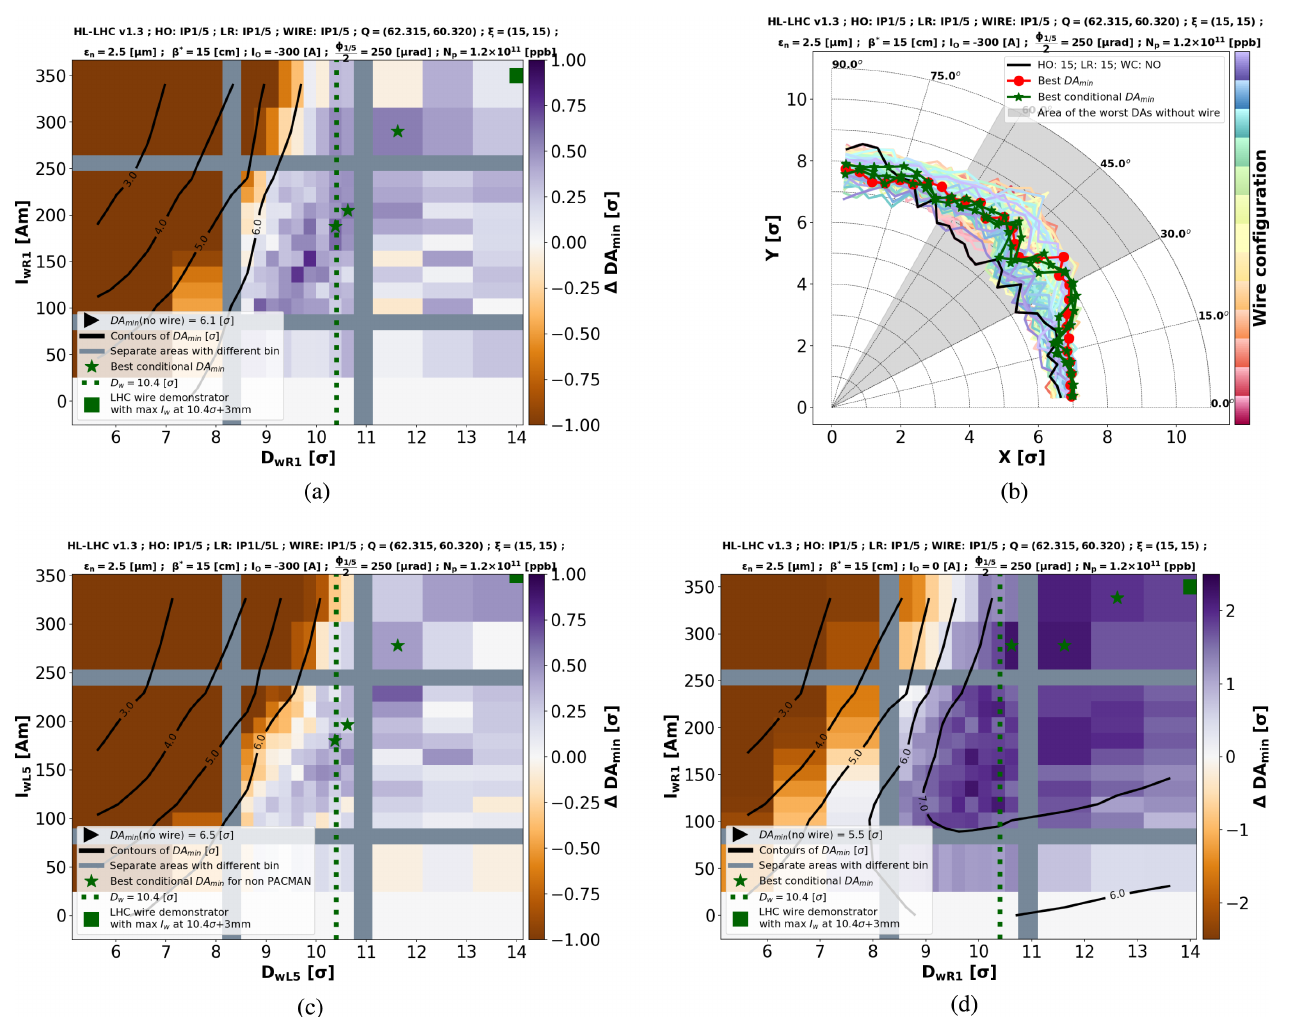
FIG. 4. HL-LHC nominal scenario at the end of the luminosity leveling. (a) The minimum DA difference from the case without wire ( Δ DA ) for different dc wire configurations and (b) DA values vs angles for the wire configurations that guarantee DA min (no wire). (c) Δ DA for PACMAN bunches using different wire configurations. (d) Δ DA min Landau octupoles ( I o ¼ 0